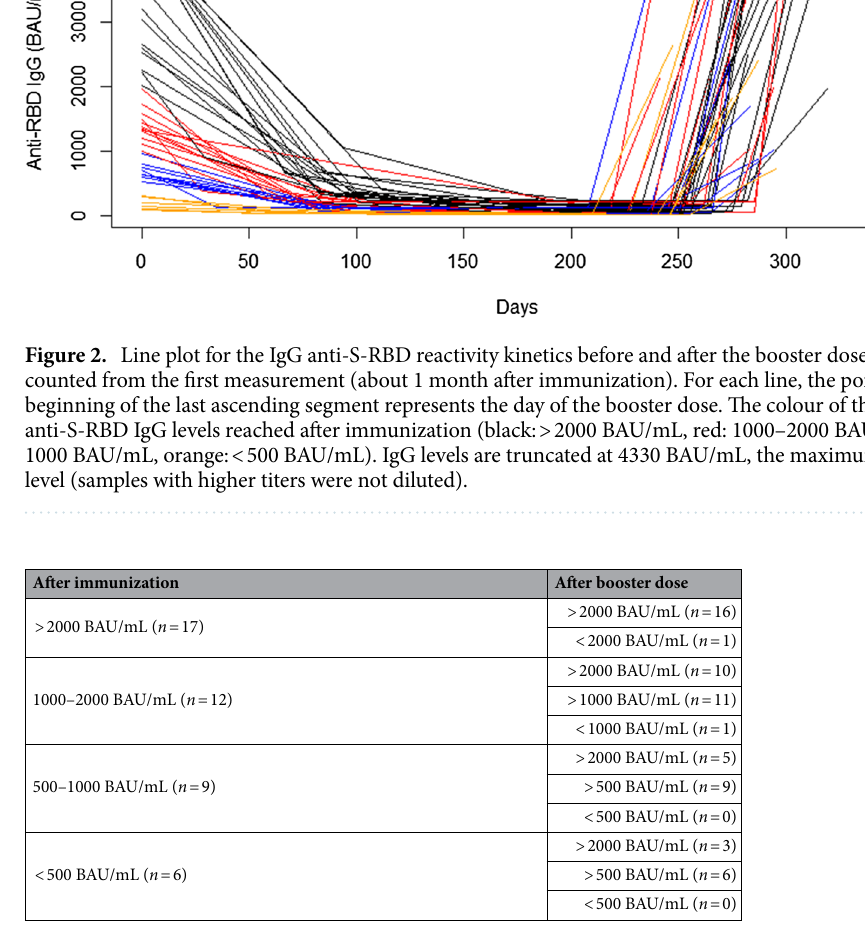
Table 2. Anti-S-RBD IgG reactivity after immunization (or baseline, column 1) and after the booster dose (column 2). Individuals were sub-grouped according to their reactivity after immunization (rows). Columns 2 reports, for each group, the number of patients with high anti-S-RBD reactivity (post-dose IgG > 2000 BAU/ mL), comparable reactivity (post-dose anti-S-RBD IgG as baseline) and lower reactivity (post-dose anti-S-RBD IgG <